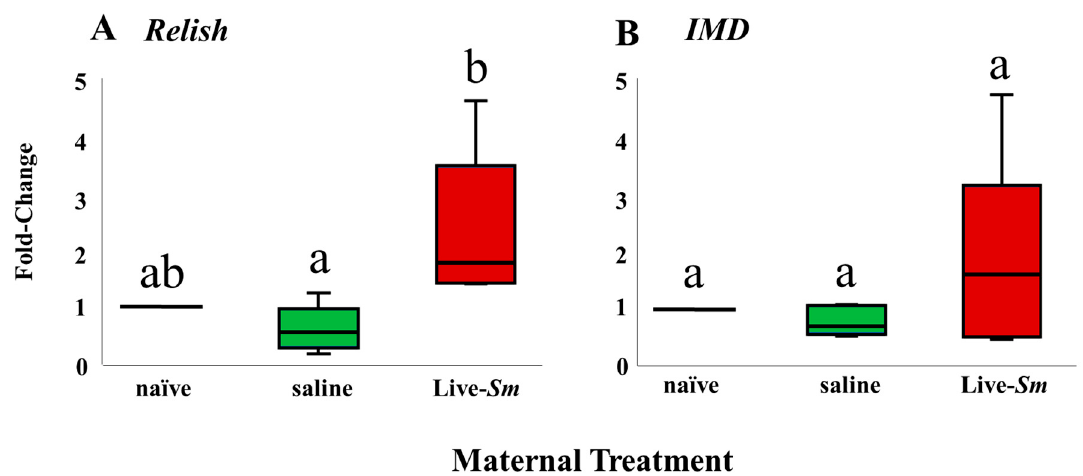
Figure 2. Fold transcript abundance di ff erences of two immune-related loci, Relish ( a ) and IMD ( b ), as a function of maternal treatment; n = 5 samples consisting of five pooled embryos. Bars ( ± SEM) represent gene dysregulation relative to “naïve” samples (which were normalized to 1). Di ff erent letters denote statistical significance across pairwise comparisons for all three treatments.